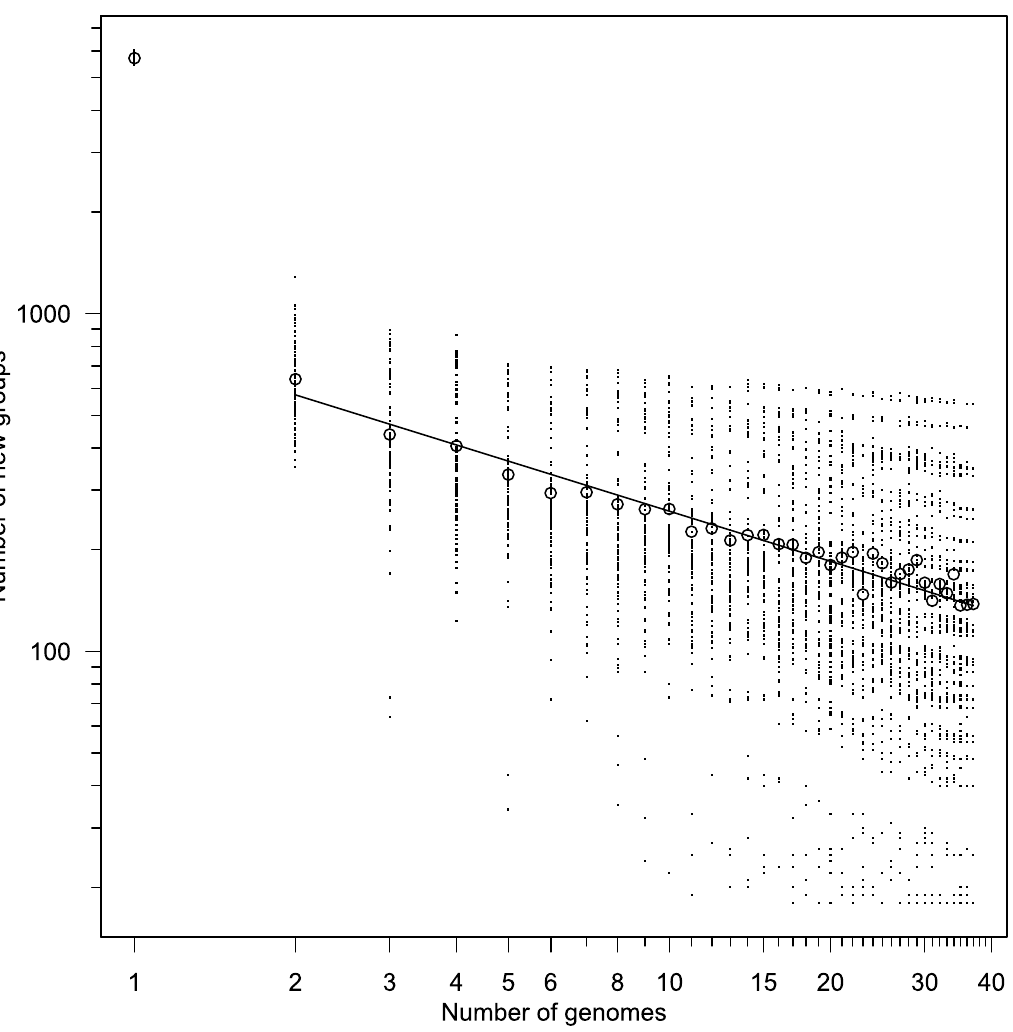
Fig 5. Number of new genes added to pangenome with addition of each genome. The order genomes were added was permuted 100 times, with the mean shown as circles. The fitted line is N ( n ) = 809 n − 0.49 and excludes the data from the first genome.